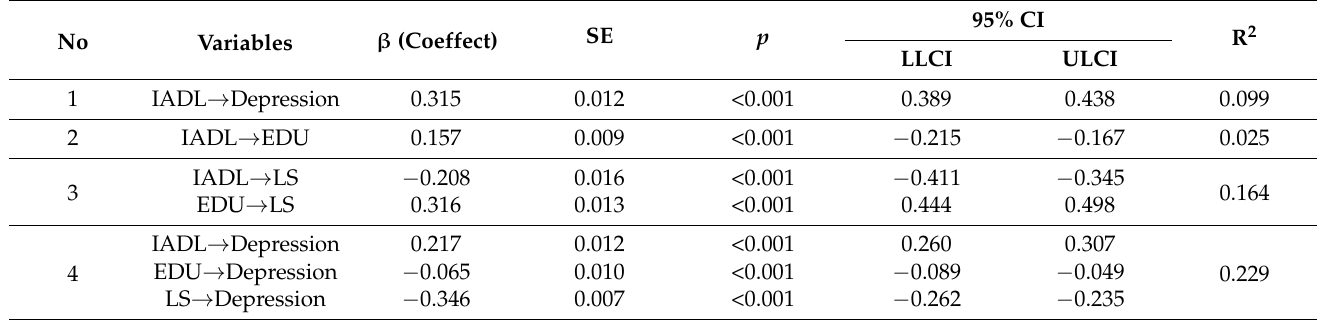
Table 4. Mediating effect of EDU and life satisfaction on the relationship between IADL and depres- sion in the older adults ( n = 9906).